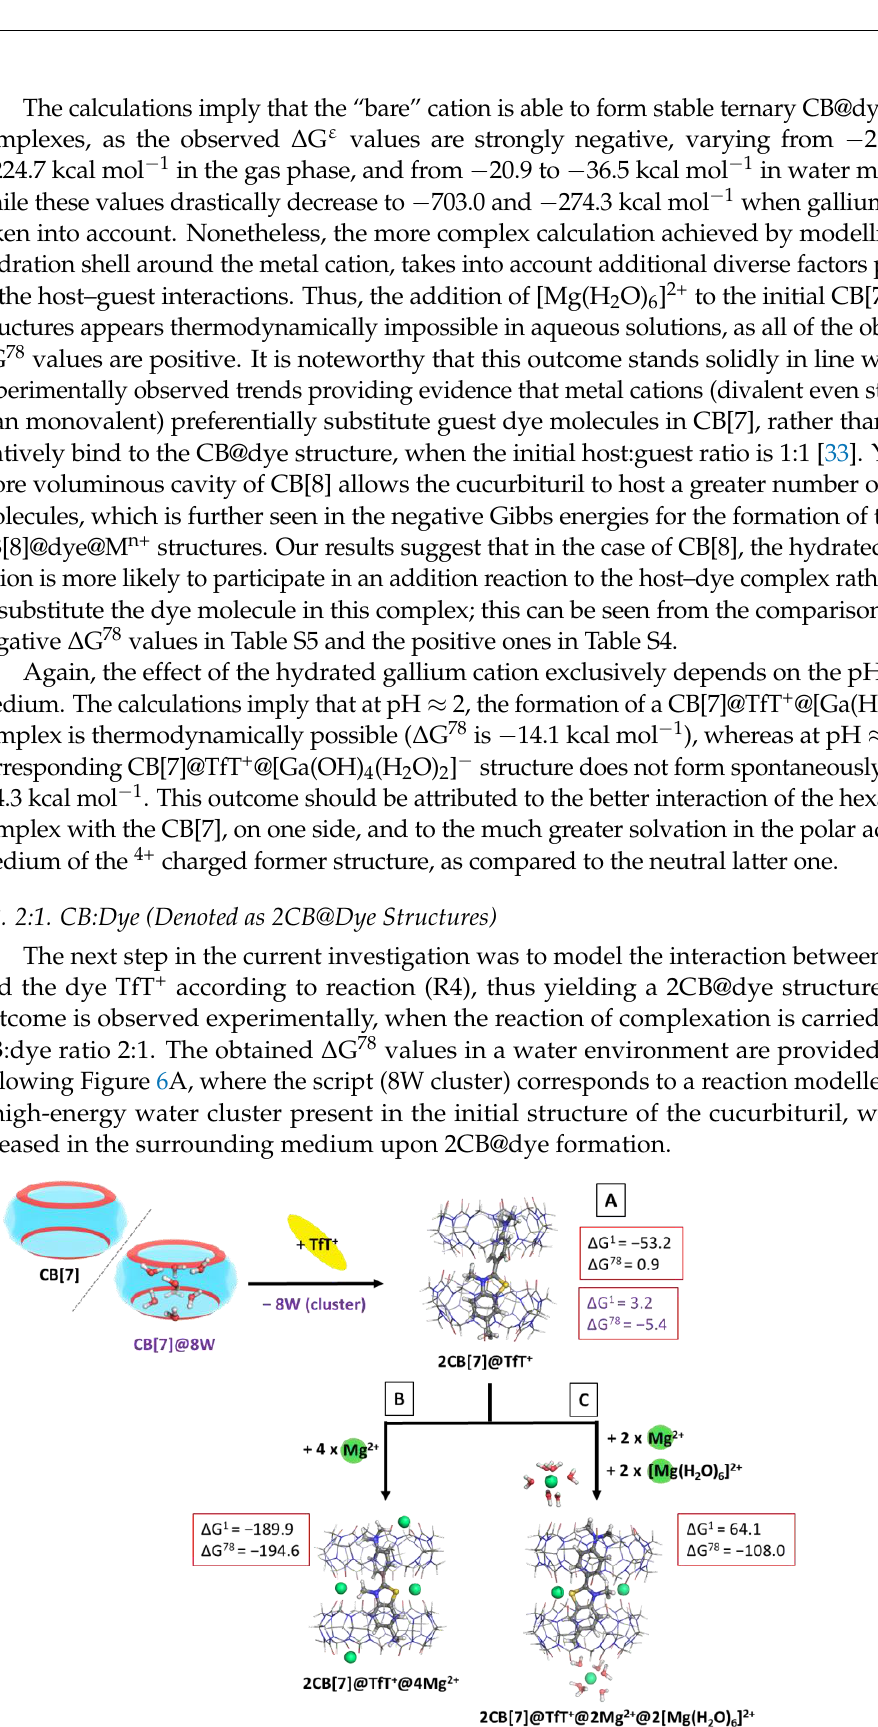
Figure 6. M062X/6 − 31G(d,p) optimized structures of the 2CB[7]@TfT + ( A ), 2CB[7]@TfT + @4Mg 2+ Figure 6. M062X/6 −3 1G(d,p) optimized structures of the 2CB[7]@TfT + ( A ), 2CB[7]@TfT + @4Mg 2+ ( B ) ( B ) and 2CB[7]@TfT+@2Mg 2+ @2[Mg(H 2 O) 6 ] 2+ ( C ) complexes in the gas phase and the and 2CB[7]@TfT + @2Mg 2+ @2[Mg(H 2 O) 6 ] 2+ ( C ) complexes in the gas phase and the corresponding ∆G ε values in kcal mol −1 for their formation in the gas phase ( ε=1 ), and water ( ε=78 ) at the M062X/6 −3 1+G(d,p)//M062X/6 −3 1G(d,p) level of theory by cooperatively binding the metal to the already formed 2CB[7]@TfT + complex. ( A ) The reaction is modelled by considering either CB[7] alone (results in black) or the cucurbituril with high-energy water molecules (results in purple) as an initial structure. The coming TfT + fully substitutes the water cluster from the host cavity. The further addition of Mg 2+ cations is computed by considering the bare ( B ) and hydrated ( C ) metal cations at the cavitand’s portals, whereas bare Mg 2+ due to steric hindrance occupy the intersection between the two host molecules. The performed calculations provide evidence of the possible complexation between CB[7] and TfT + in a 2:1 ratio, as t he ∆G 78 value is very close to zero (0.9 kcal mol −1 ), which is near the error of the method. On the other hand, when taking into account the probable presence of a high-energy water cluster in the initial structure of the cucurbituril, the result decreases to −5 .4 kcal mol −1 , thus indicating the plausible host – guest interaction. These results stay firmly in line with the experimentally observed trends [33]. 2.8.1. Forming Molecular Architectures An intriguing aspect of the metal-assisted complexation of fluorogenic dyes by cu- curbiturils is the effect of divalent cations on the 2CB[7]@TfT + complex. Unexpectedly, the metal cations associate cooperatively to the structure, as experimentally observed [33], thus enhancing the fluorescent yield manifold. Therefore, we modelled the effect of mag- nesium cations added to the 2CB[7]@TfT + complex according to reaction (5). The obtained results are depicted in Figure 6B,C. It is noteworthy that our theoretical results strongly correspond to the experimentally provided ones, as the addition of magnesium cations distinctively decreases the calcu- lated Gibbs energies of complexation: −1 89.9/ −1 94.6 and 64.1/ −1 08.0 kcal mol −1 for the for- mation of 2CB[7]@TfT + @4Mg 2+ and 2CB[7]@TfT + @2Mg 2+ @2[Mg(H 2 O) 6 ] (Figure 6B,C), as compared to 0.9/ −5 .4 kcal mol −1 for the formation of 2CB[7]@TfT + (Figure 6A). This indi- cates a strong inclination toward the formation of a highly fluorescent supramolecular nanocapsule, mainly due to the stabilization provided by the magnesium cations not only as lids at the two outer portals of the CB[7], but also at the intersection amid the host molecules. Furthermore, the arising ion – dipole interactions of attraction between the metal cations and the carbonyl groups are seen in the charge transferred in the region of the O-atoms: it is by 0.01 to 0.06e - greater (Hirshfeld analysis) as compared to the metal-